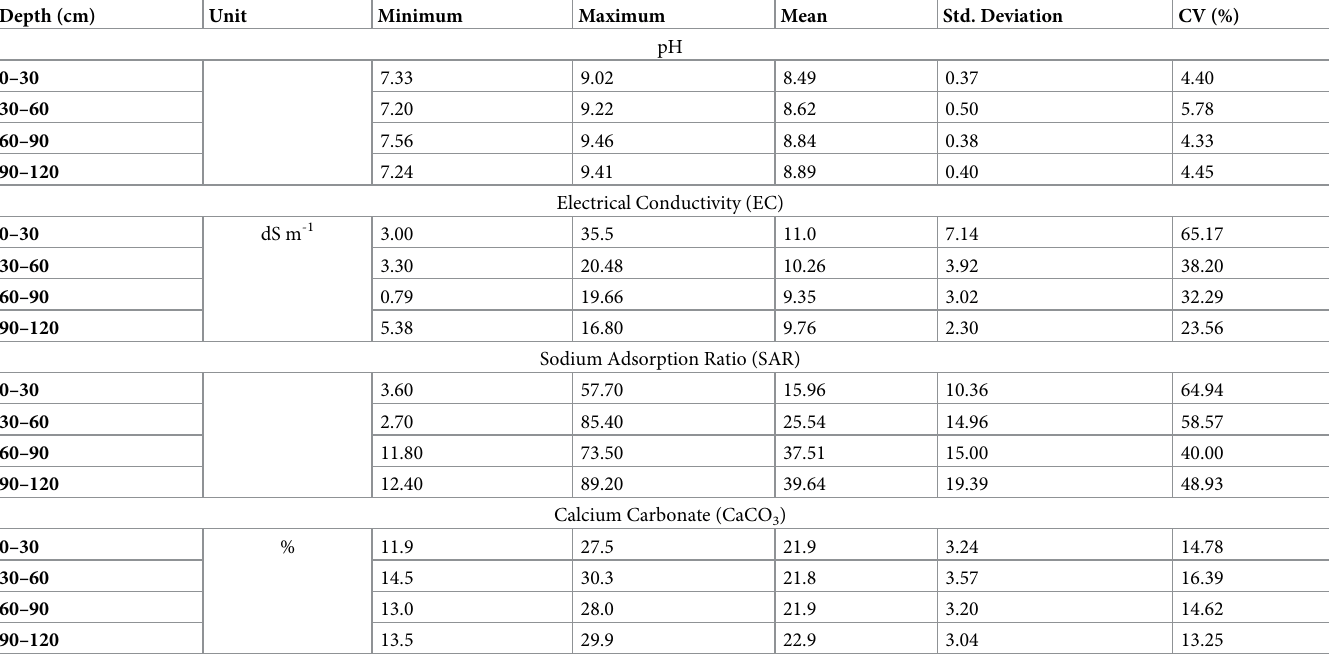
layers (Table 3). The high CV values of soil salinity (EC) and SAR indicated that there is a Table 3. Mean soil reaction, electrical conductivity and calcium carbonate content in the study area. Depth